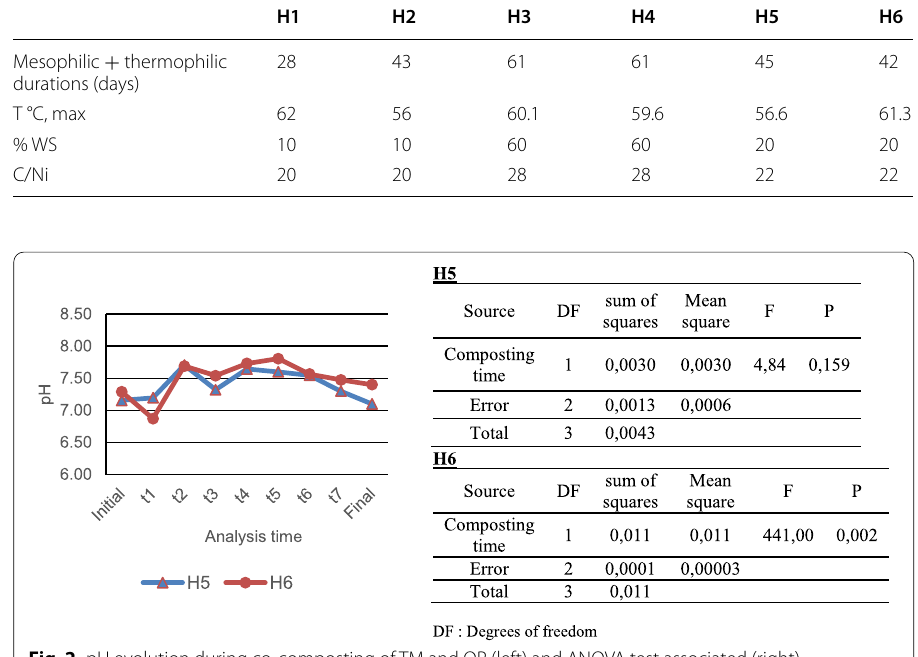
Fig. 2 pH evolution during co‑composting of TM and OP (left) and ANOVA test associated